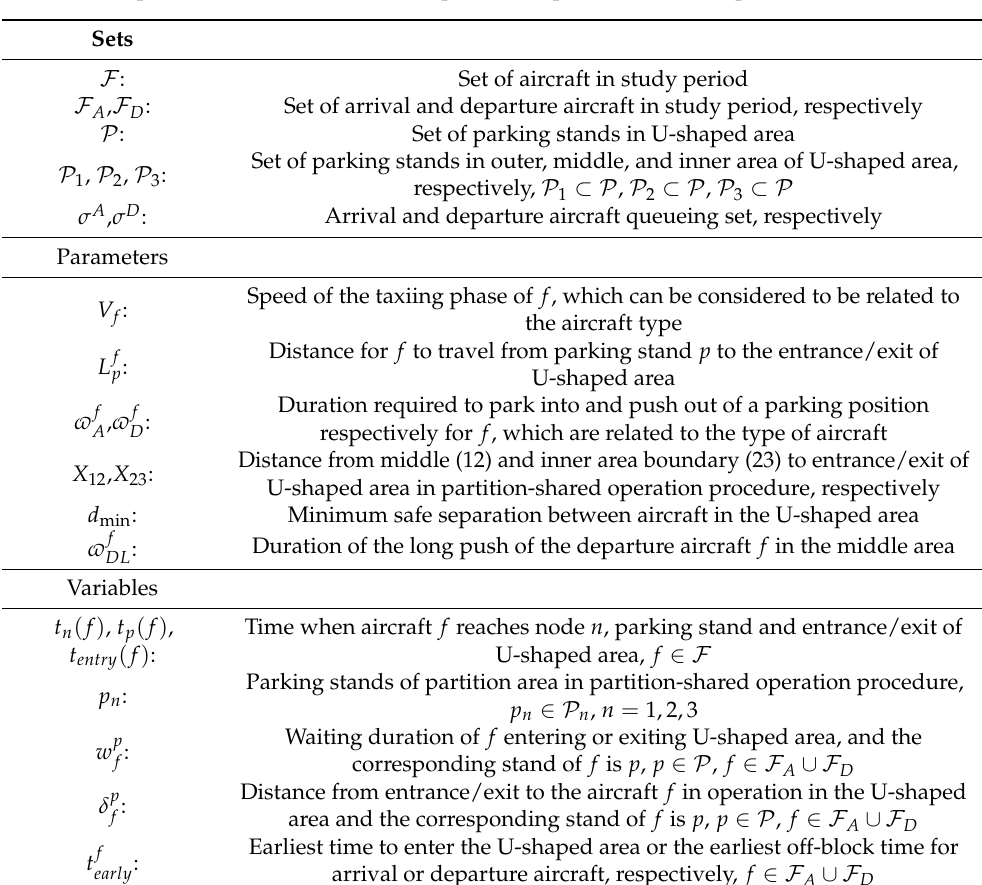
Table 1. Sets, parameters, and variables of Apron U-shaped Area Traffic Operation